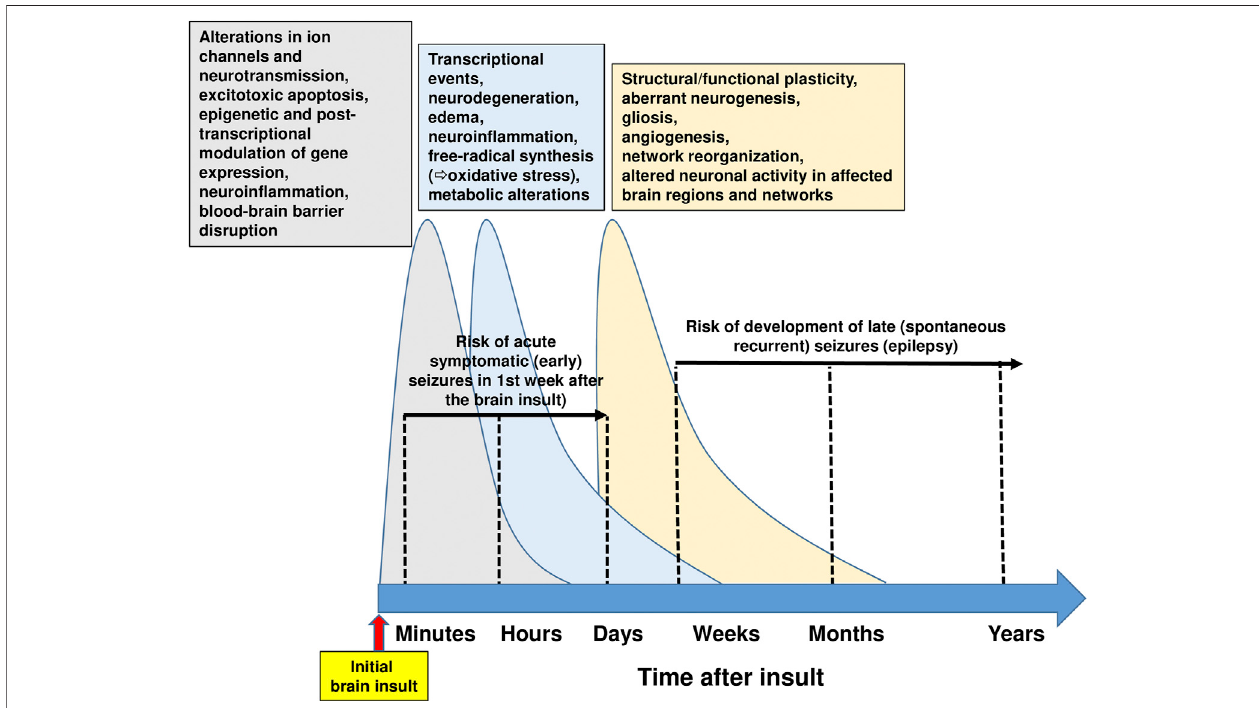
FIGURE 7 | Time course of pathophysiological brain alterations after an initial brain insult. Initial brain injuries comprise traumatic brain injury, stroke, hypoxic- ischemicencephalopathy,braininfections,orprolongedseizuressuchascomplexfebrileseizuresorstatusepilepticus.Thecomplexmolecular,structuralandfunctional alterations, which underlie the motor, cognitive, and behavioral abnormalities and the spontaneous recurrent seizures (i.e., epilepsy) that may develop after brain injury, exhibit commonalities across different brain insults, thus providing an opportunity for therapeutic intervention. Following brain injuries as illustrated here, the cascade of events that are primarily suggested by experimental evidence can be classi fi ed temporally following the initial insult into 1) early changes (including post- translational modi fi cation of receptor and ion-channel related proteins), which occur within seconds to minutes; 2) more retarded changes (e.g., neuronal death, in fl ammation,alteredtranscriptionalregulationofgenes),whichoccurwithinhourstodays;and3)laterchanges(includingmorphologicalalterationssuchasmossy fi ber sprouting, gliosis, and neurogenesis), occurring days to weeks to months after the initial insult. These molecular, structural and functional alterations eventually lead to structuralandfunctionalchangesinneuronsandneuronalnetworks,whichareeventuallymanifestedasabnormalhyperexcitabilityandspontaneousseizures.Notethat acute symptomatic (early) seizures that may occur in the fi rst week after brain injury are not considered spontaneous seizures. Current drug therapy of spontaneous seizures is symptomatic in that available antiseizure medications inhibit seizures, but neither effective prophylaxis nor cure is available. The complexity of the alterations illustratedinthis fi gureindicatesthatmulti-targeteddrugcombinationtherapyisneeded fordiseasemodi fi cation. However, pleasenotethatpartofthemultiple changes after brain injury may be aimed to repair or reverse the detrimental consequences of the insult. For instance, secondary neuroin fl ammation both promotes further injury, resultingincelldeath,butconverselyplaysabene fi cialrole,bypromotingrecovery(Jayakaretal.,2019).FordetailsseeRakhadeandJensen(2009),ClossenandReddy (2017), Klein et al., 2018), Somayaji et al. (2018), Campbell et al., 2019, and Löscher